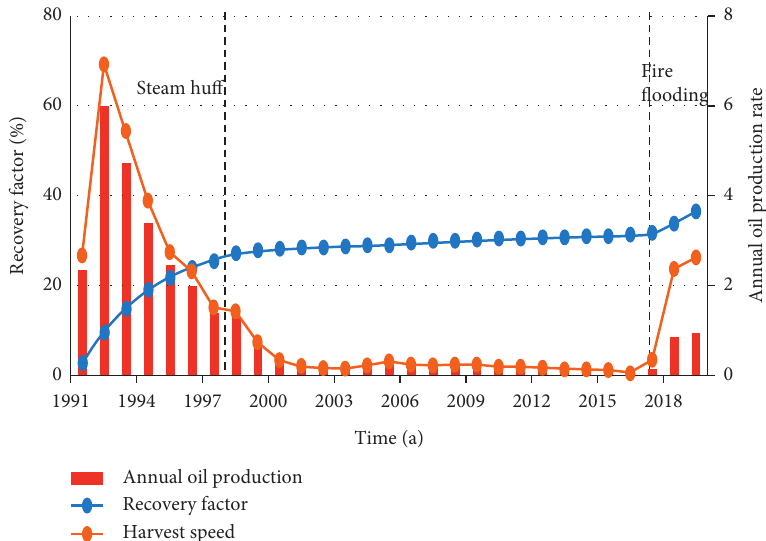
Figure 5: Variation curve of the production and oil production rate of the fire flooding industrialization test in the Hongqian1 district.